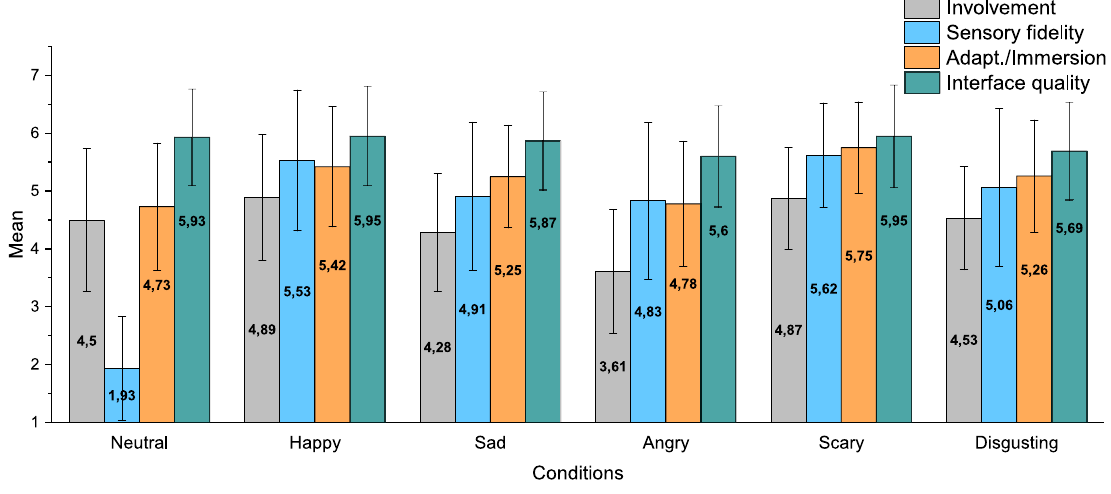
Figure 3. Exp. 1—presence mean rates for each experimental